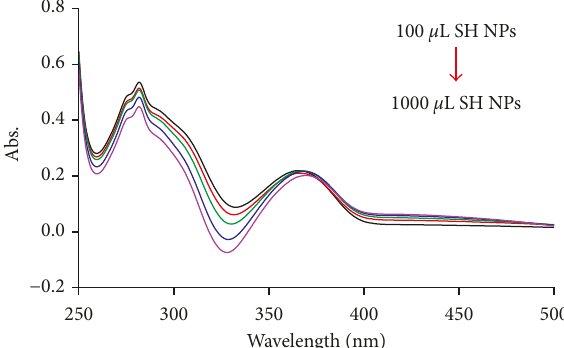
4 mol 1 ATN and 5 10 L × · − −